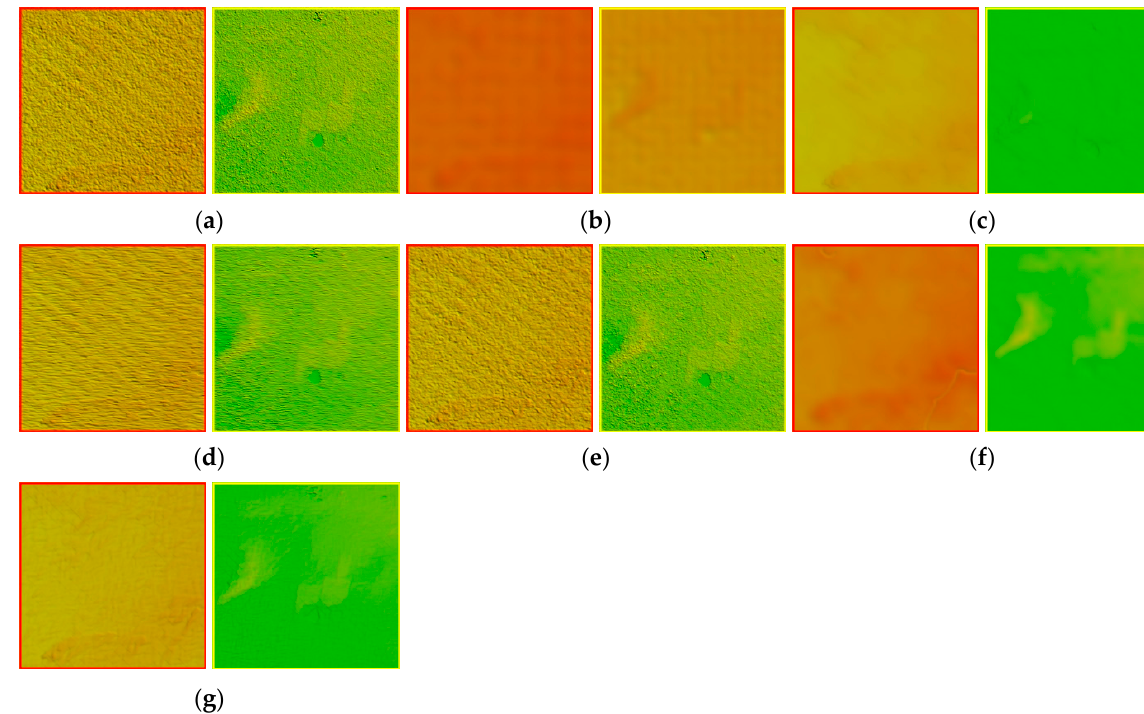
Figure 13. Results of the real experiment for the local enlargement of area S35E144 (Figure 12). Local enlargements for ( a ) area S35E144, ( b ) low-pass filter, ( c ) TV, ( d ) UTV, ( e ) LRSID, ( f ) Gallant and ( g ) LRGS. Figure 14 show the effect of processing using various methods on real area S36E144 for visual evaluation. Figure 15 show partial enlargements of the corresponding data.